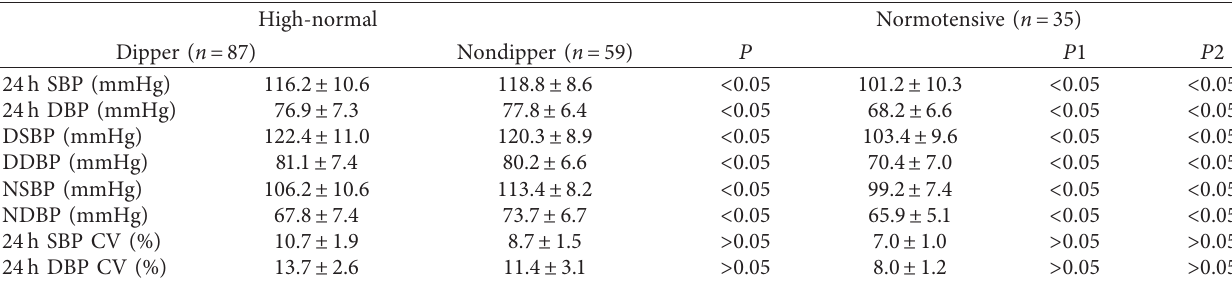
Table 2: ABPM findings of high-normal and normotensive patients provided separately for dippers and